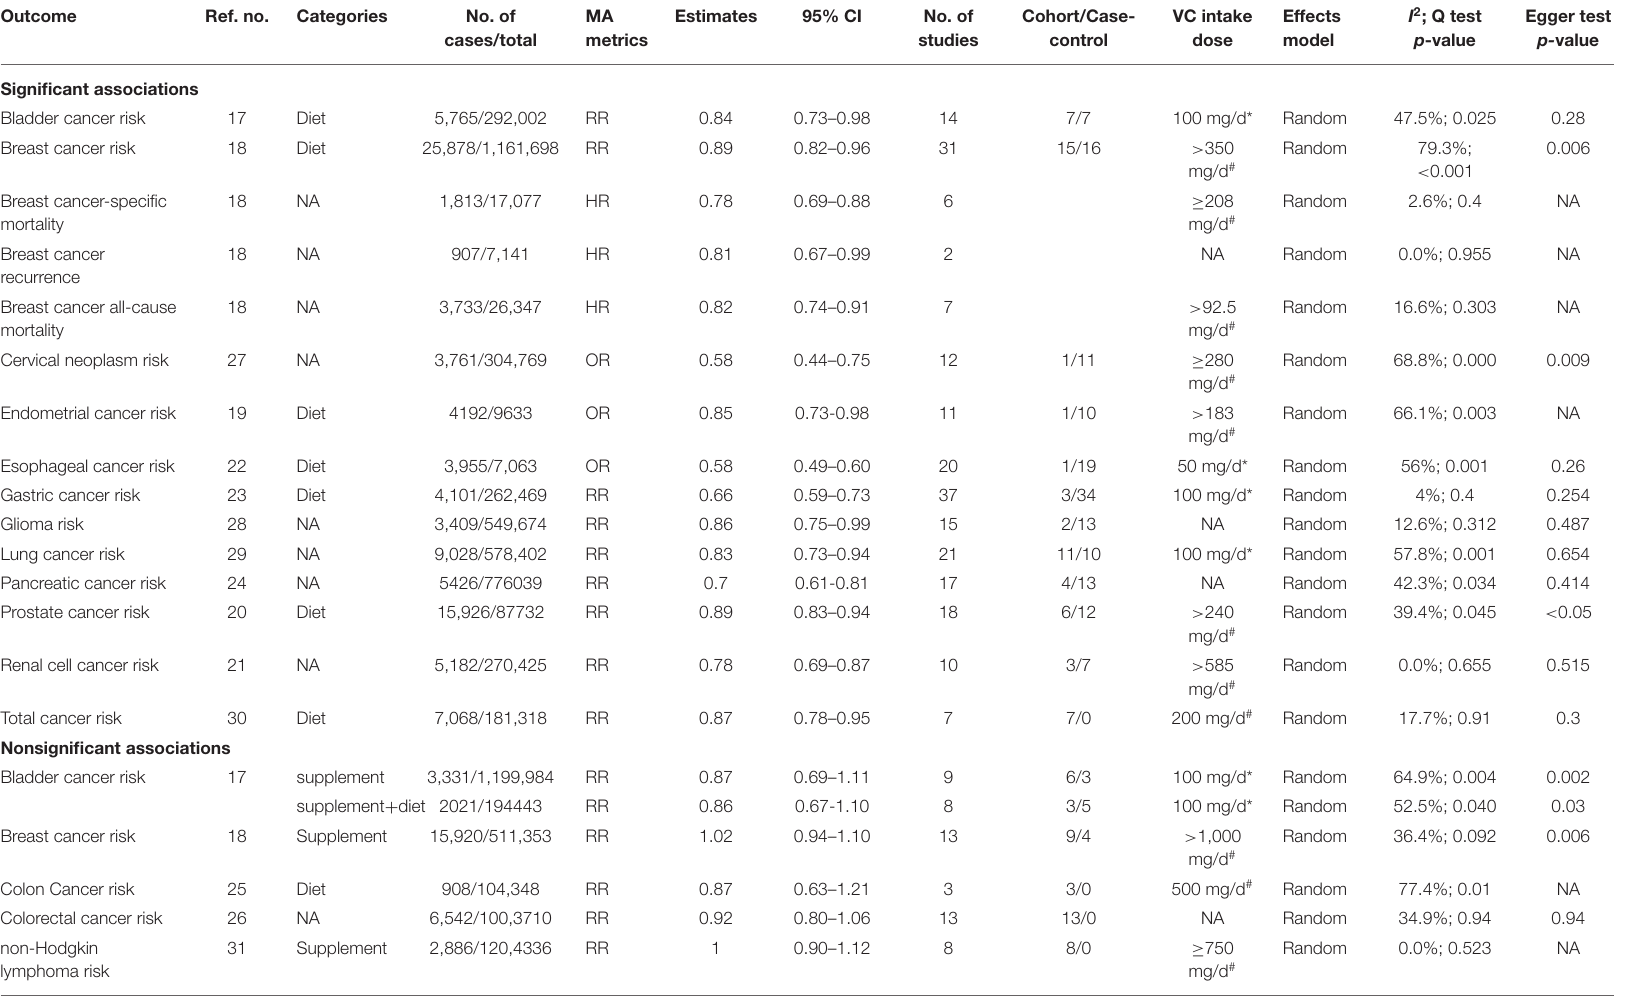
# Maximum dose of VC intake. * Increment dose of VC